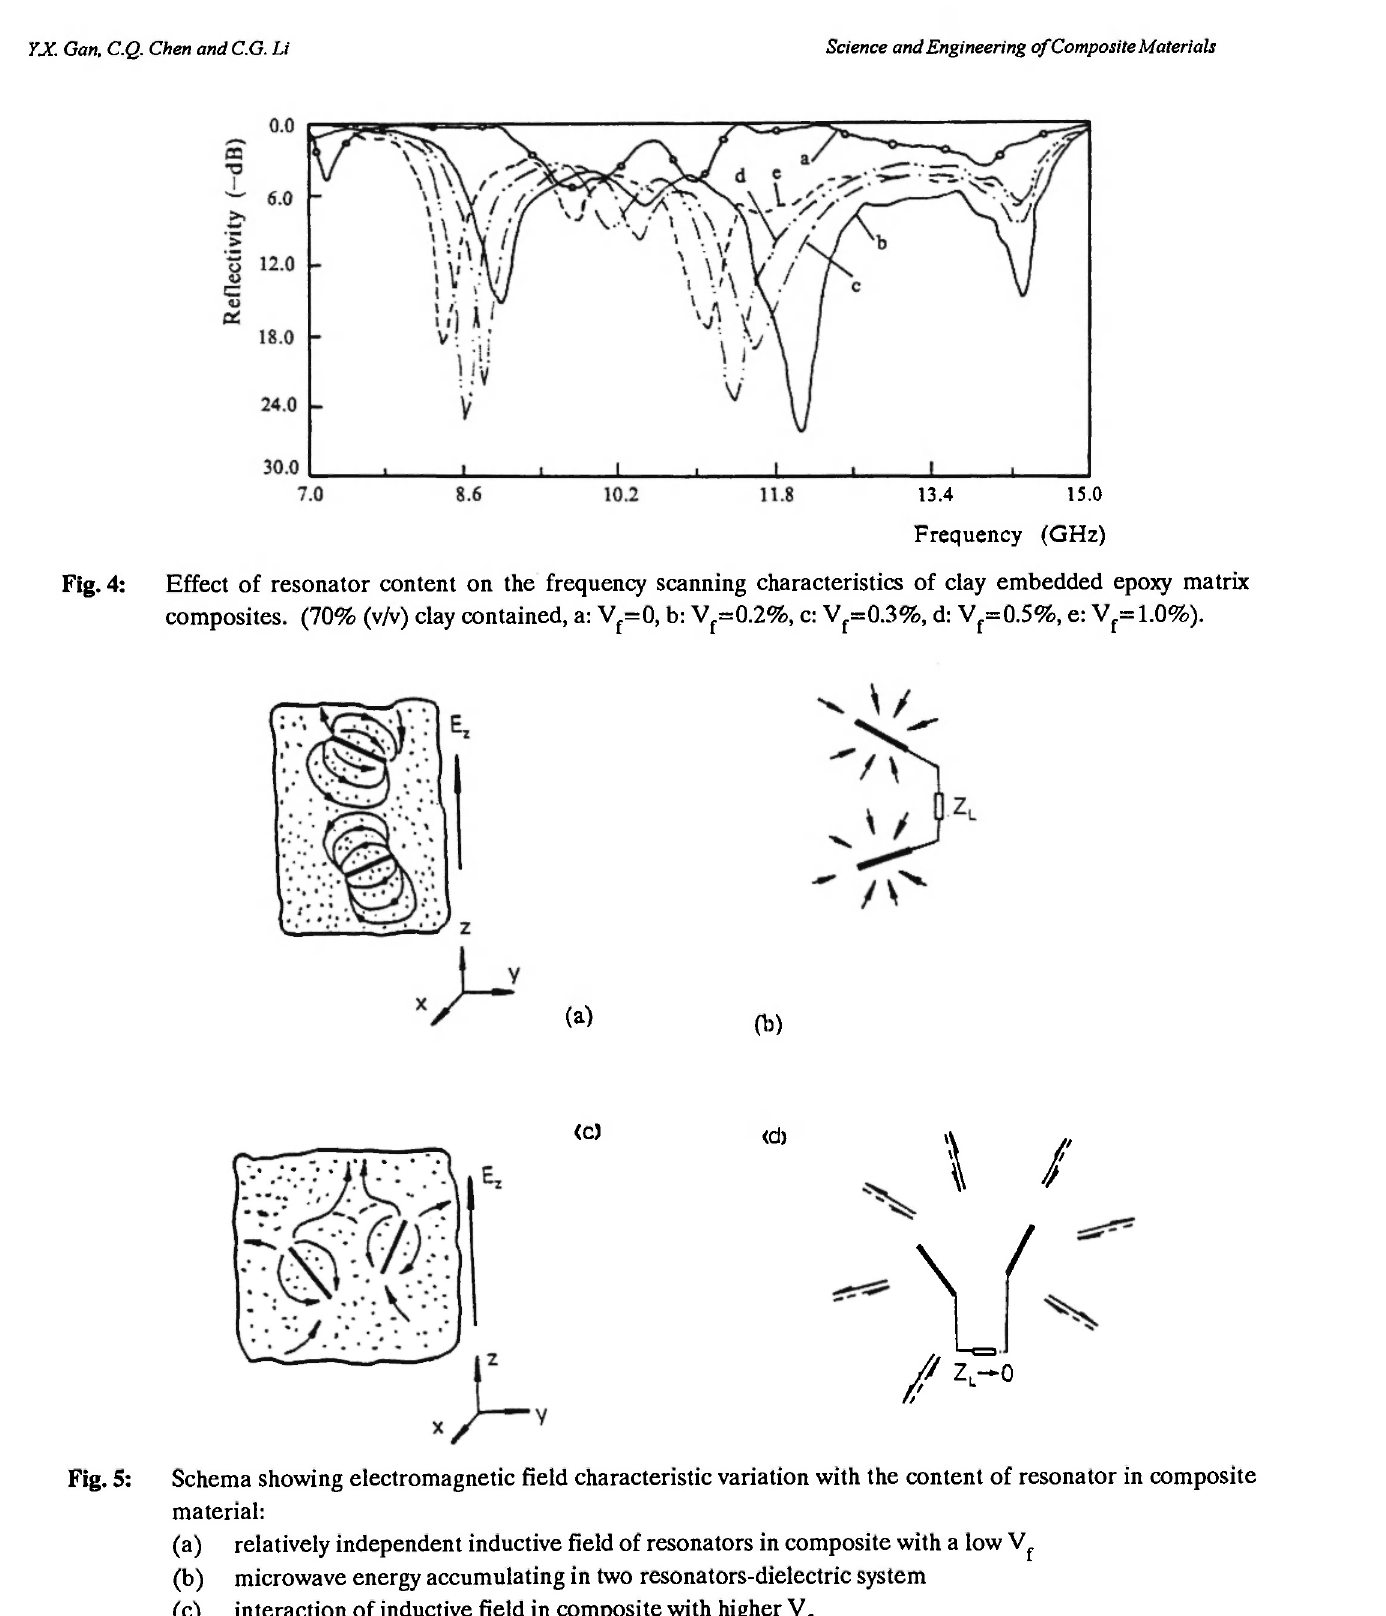
Schema showing electromagnetic field characteristic variation with the content of resonator in composite